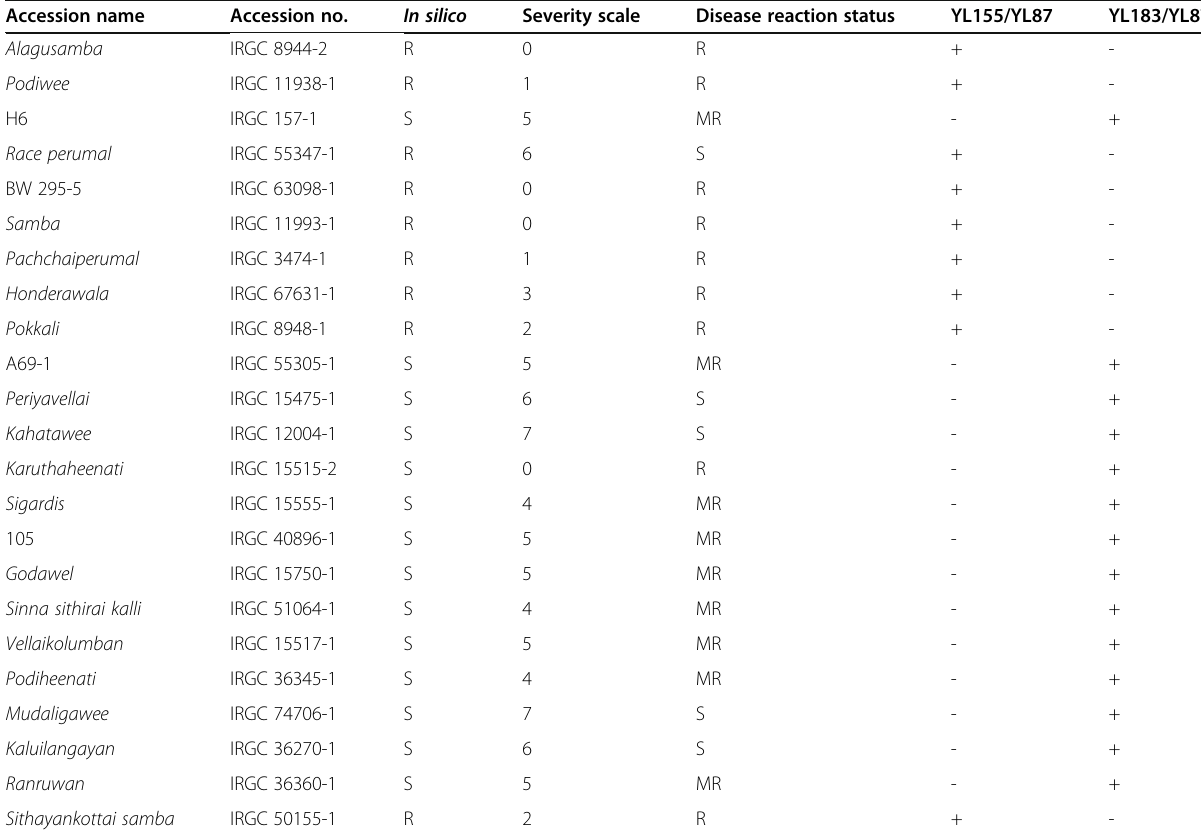
Table 4 Overview of the results for the assays conducted to evaluate the presence of Pi-ta gene in Sri Lankan rice accessions (PGRC — Plant Genetic Resources Institute of Sri Lanka; R resistant, S susceptible; ‘ + ’ represents the presence and ‘ - ’ represents the absence of amplicons in the specific PCR assays).